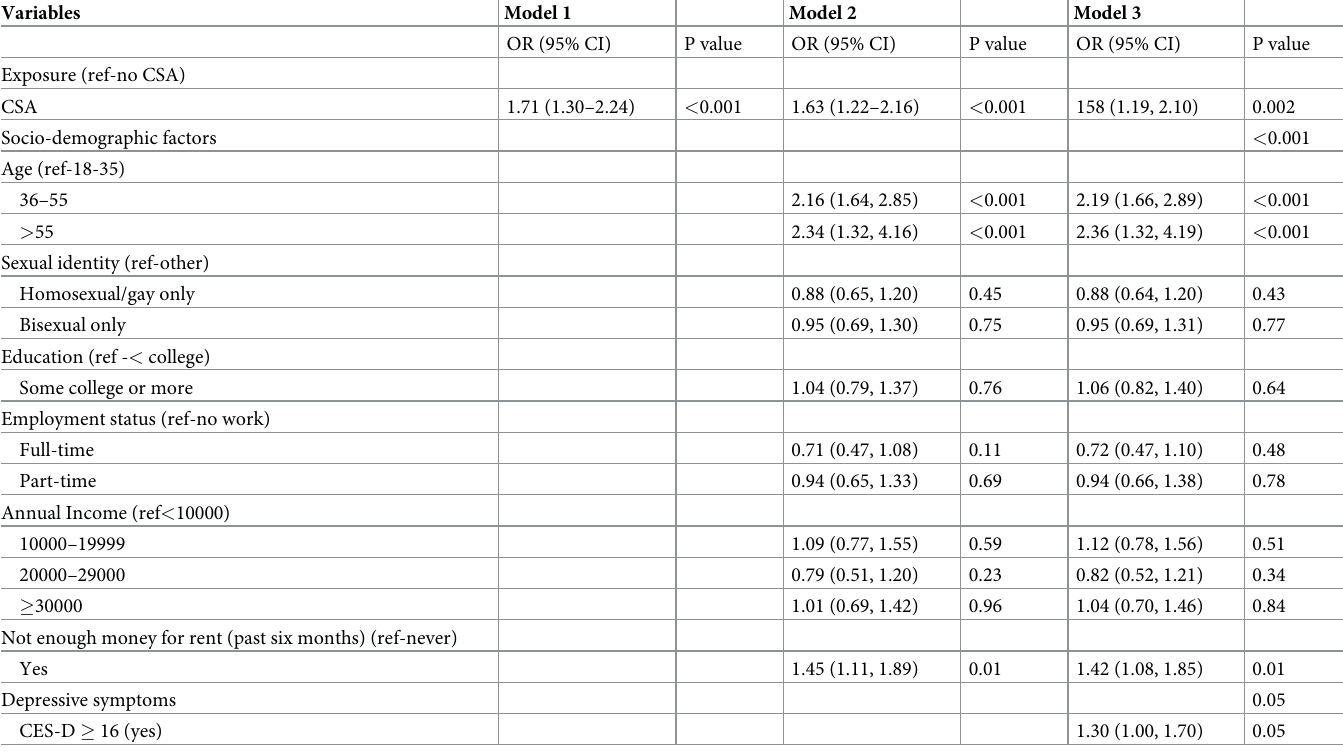
Our data align with results from a study by Wu (2018) which found 28% CSA prevalence in a New York City sample of 1,002 Black SMM. In that study, CSA history was associated with 50% greater odds of both binge drinking and illicit substance use, which are in line with our findings. However, the prevalence of any CSA was substantially higher in our sample (70%) compared to findings reported in the Wu study, which might reflect a crucial difference in study inclusion criteria. Our study included Black SMM who reported condomless sex during the past six months whereas the study by Wu included Black SMM who reported any sex in the past three months regardless of condom use or nonuse. Indeed, previous research has indi- cated that CSA is associated with higher rates of condomless sex and HIV risk [29], potentially accounting for the high CSA prevalence in our sample. Moreover, in a previous systematic Table 3. Variables associated with drug use: Results from hierarchical logistic regression models (N = 1016).